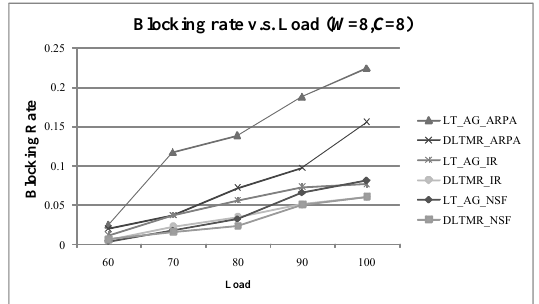
Fig. 10. Blocking rate vs. traffic load ( W =8, C =8)